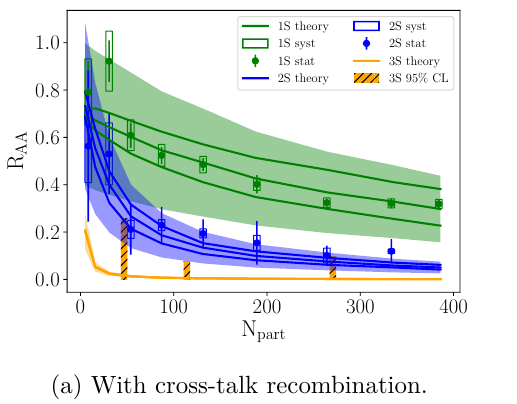
Figure 3. Bottomonia R AA as functions of centrality at 5 . 02 TeV Pb-Pb collisions. The upper and lower curves correspond to calculations with parameters that differ by ± 10% respectively from the parameters used in the middle curve. The band indicates the nPDF uncertainty that is centered at the middle curve. Experimental data are taken from ref.